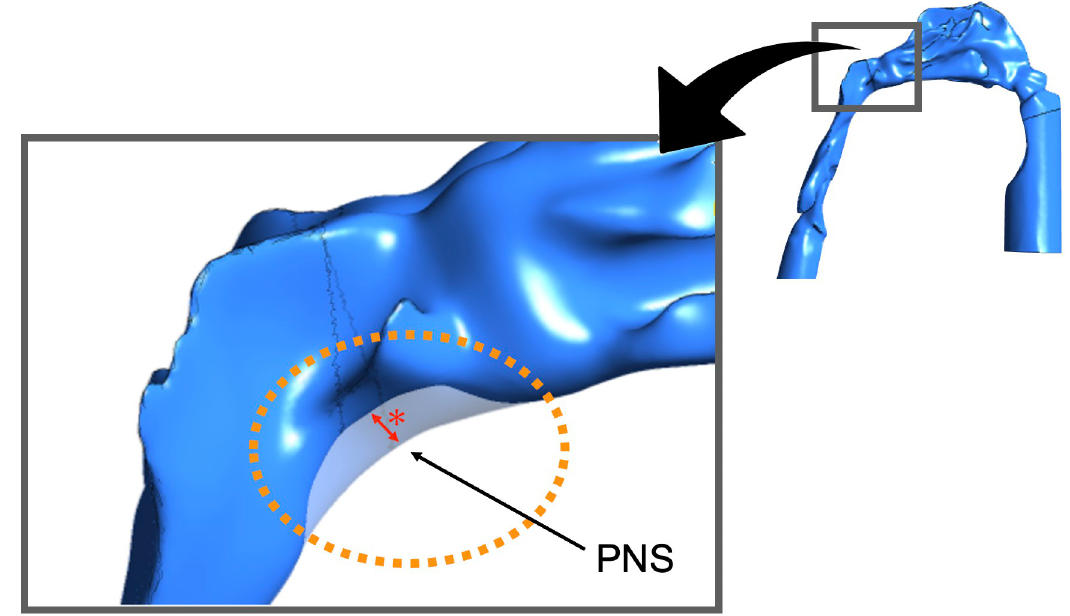
Fig 4. STENOSIS model. With a focus on the nasopharynx region of the STENOSIS model, the area (surrounded by the orange dotted circle) was trimmed by the length of the asterisk around the posterior nasal spine (PNS) in the sagittal plane. The red asterisk indicates the amount of trimming for the nasopharynx of the STENOSIS